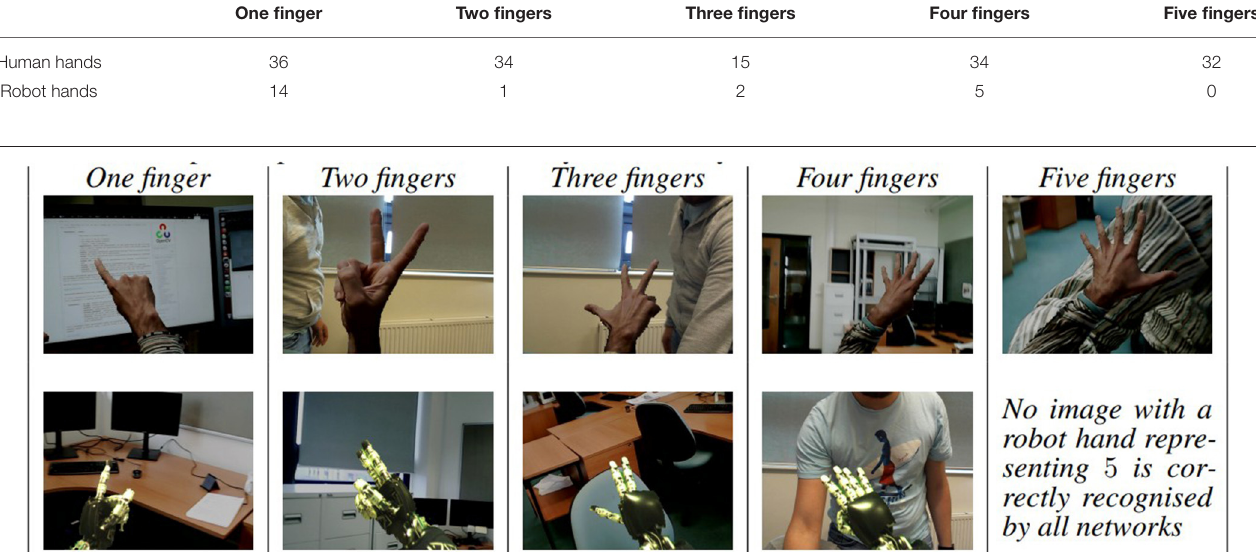
TABLE 5 | Examples of images from the subset of test images that are correctly classified by all networks.